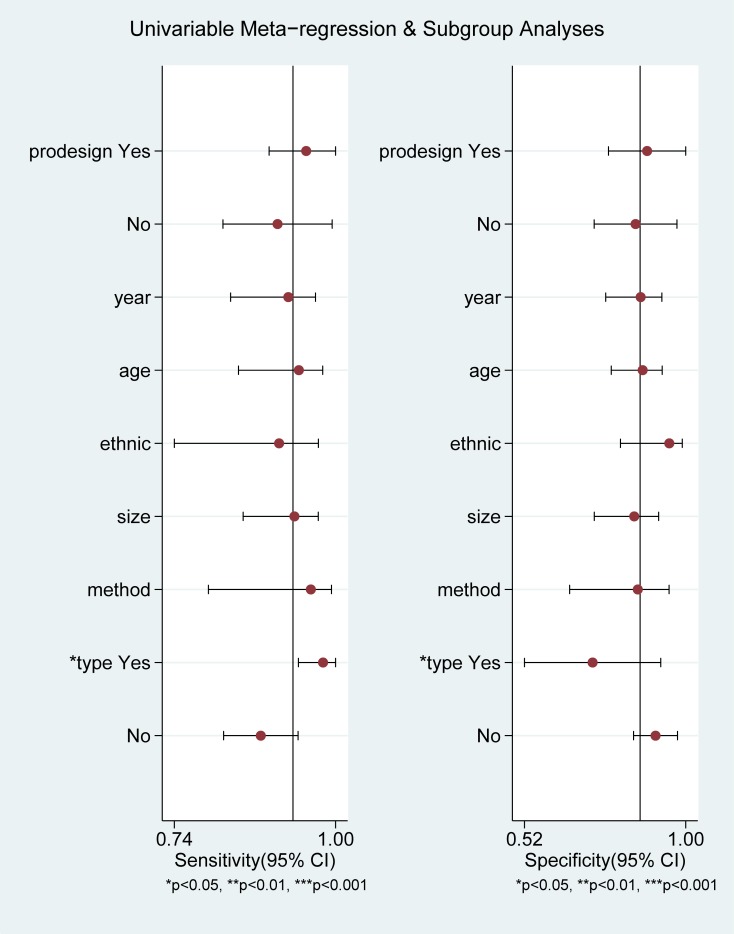
Meta-regression analysis for DOR.